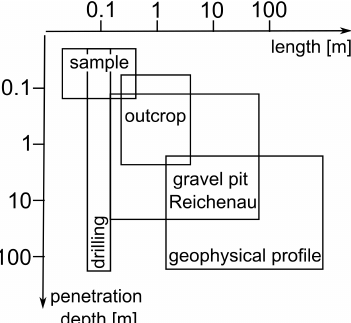
Figure 3. Schematic plot highlighting the novelty of the geophys- ical results in the framework of a complementary method applica-